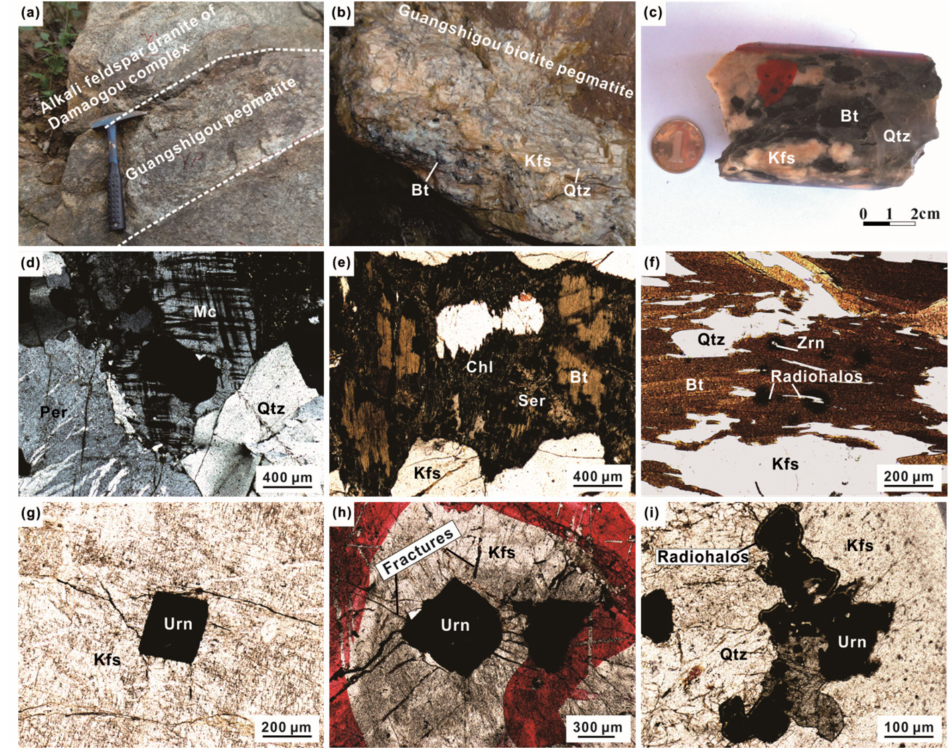
Figure 2. Photographs and optical microphotographs showing petrographic characteristics of rock- forming minerals and uraninite from the Guangshigou biotite pegmatite. ( a ) The Guangshigou pegmatite penetrates the alkali feldspar granite of the Damaogou complex. ( b ) The Guangshigou biotite pegmatite mainly consists of centimeter-sized K-feldspar, biotite, and quartz. ( c ) Hand specimen of the biotite pegmatite from the drill hole ZK1603. ( d ) K-feldspar in the biotite pegmatite is further identified as microcline and perthite. ( e ) Biotite is partially replaced by chlorite and sericite. ( f ) Radiohalos around zircon which is enclosed in biotite. ( g , h ) Euhedral uraninite grains enclosed in K-feldspar with fractures. ( i ) Radiohalos around uraninite. Abbreviations: Bt—biotite,